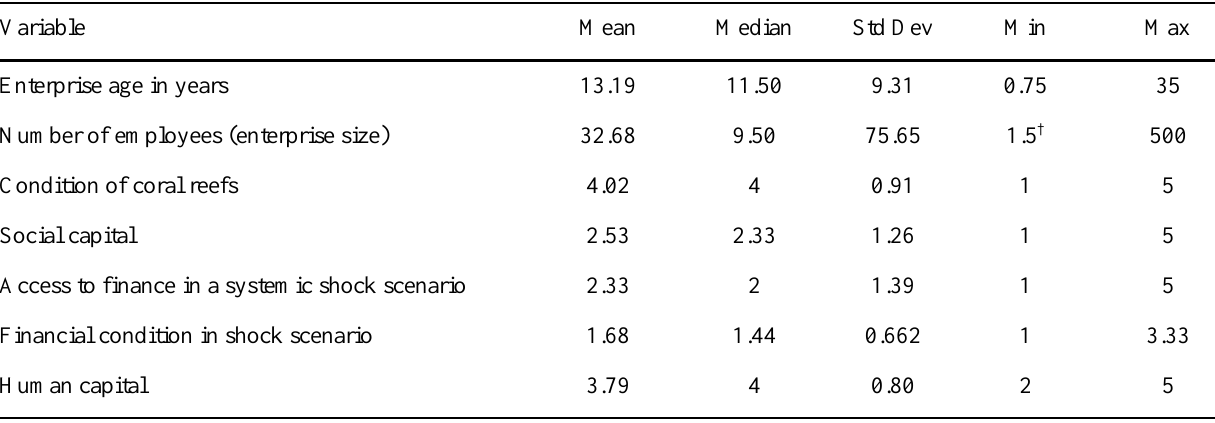
Table 5. Descriptive statistics for the single item quantitative and ordinal explanatory variables all measured on a 5 point Likert scale (1 = strongly disagree/negative, 5 = strongly agree/positive) other than enterprise